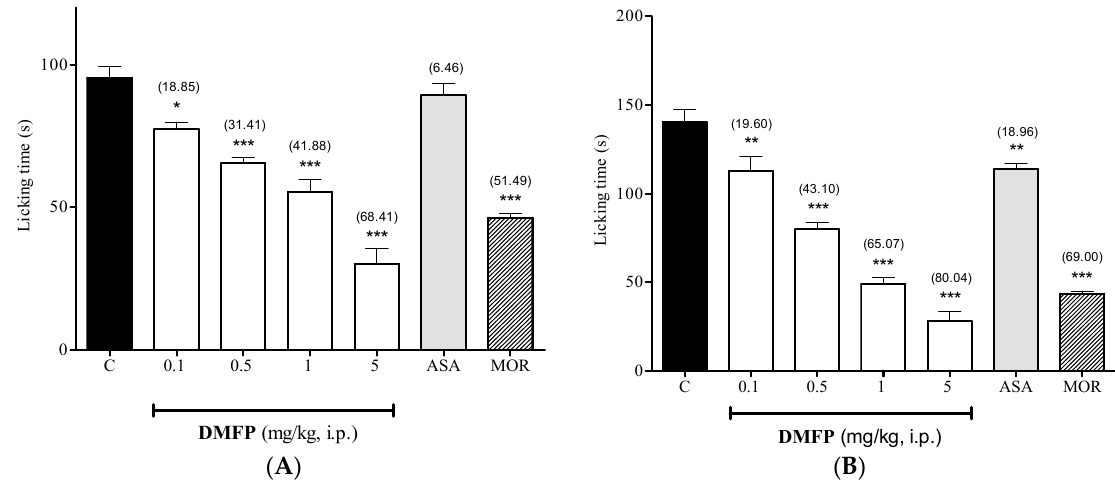
Figure 3. Effect of DMFP in formalin-induced paw-licking test (early phase, panel ( A ); and late phase, panel ( B ) in mice. Each column represents the mean ± S.E.M. ( n = 6). The mice were pretreated with vehicle C, 10 mL/kg, i.p.), DMFP (0.1, 0.5, 1.0 and 5.0 mg/kg, i.p.), acetylsalicylic acid (ASA, 100 mg/kg, i.p.) or morphine (MOR, 5 mg/kg, i.p.). The asterisks denote the significance levels * p < 0.5, ** p < 0.01, *** p < 0.001, when compared with control vehicle group. Statistical